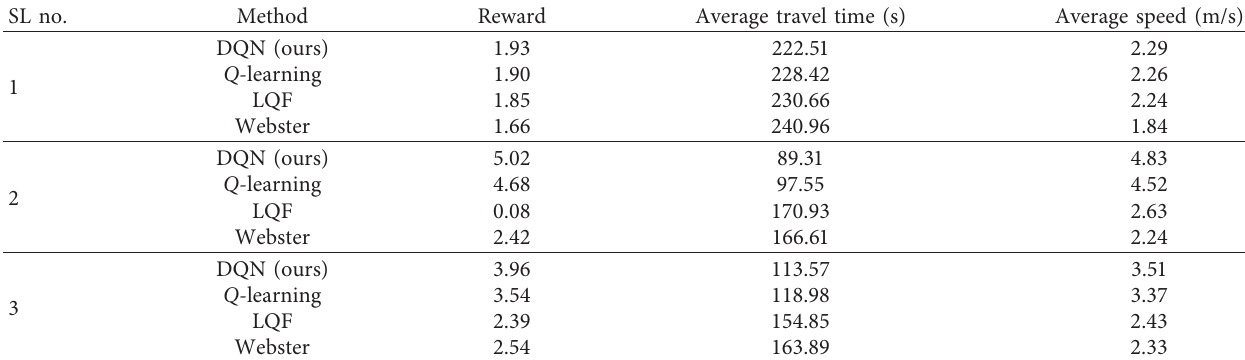
Table 3: Performance in single-intersection case. Travel time: the lower the better; other measures: the higher the better. SL